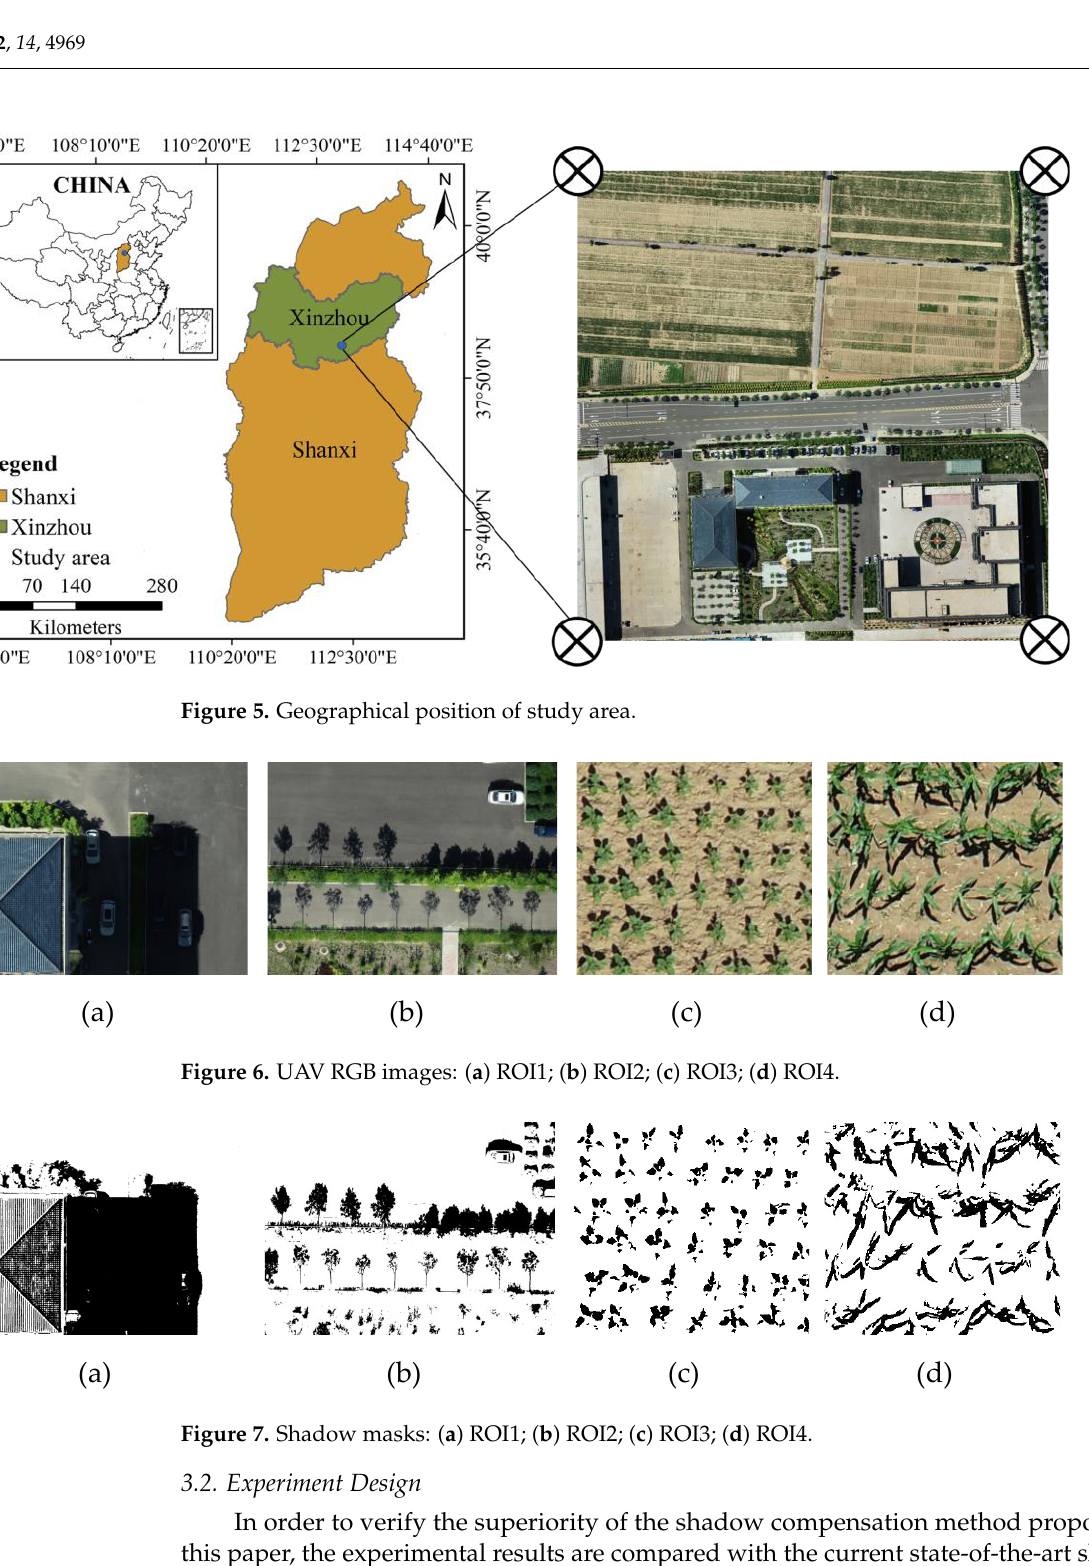
Figure 7. Shadow masks: ( a ) ROI1; ( b ) ROI2; ( c ) ROI3; ( d ) ROI4.